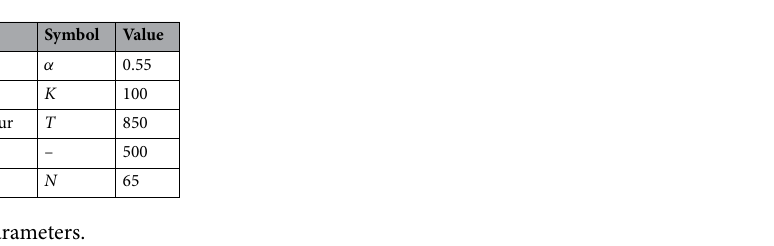
Table 1. Simulation